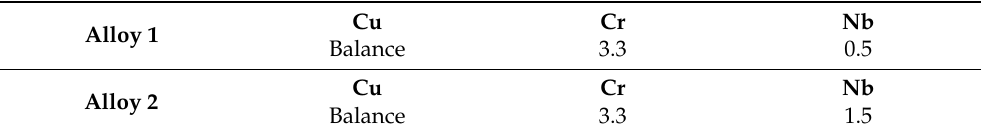
Table 1. Nominal chemical composition of the Cu-Cr-Nb powder materials in wt.%.